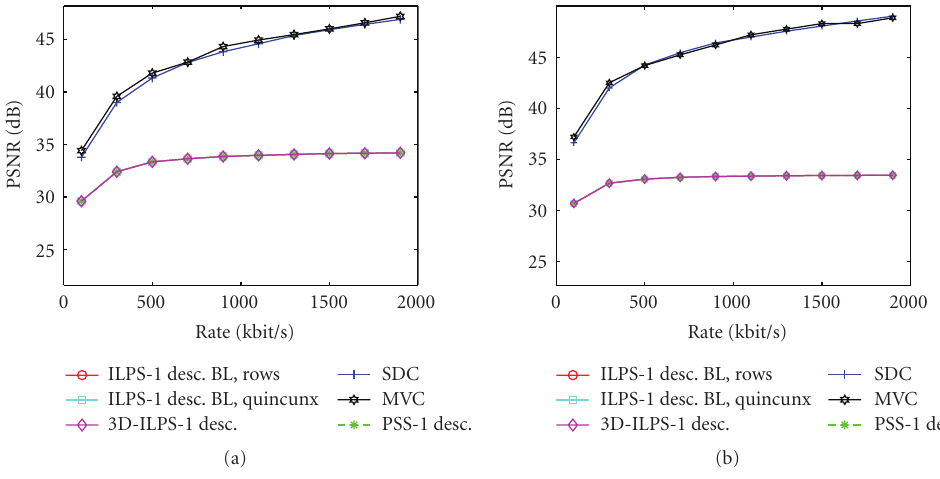
Figure 5: Performance of left view, one subsequence received. (a) Breakdance. (b) Ballet.